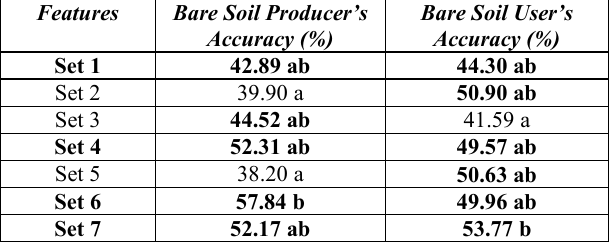
Table 10. Comparison of mean values of producer’s and user’s accuracies for “Bare Soil” class and the seven sets of